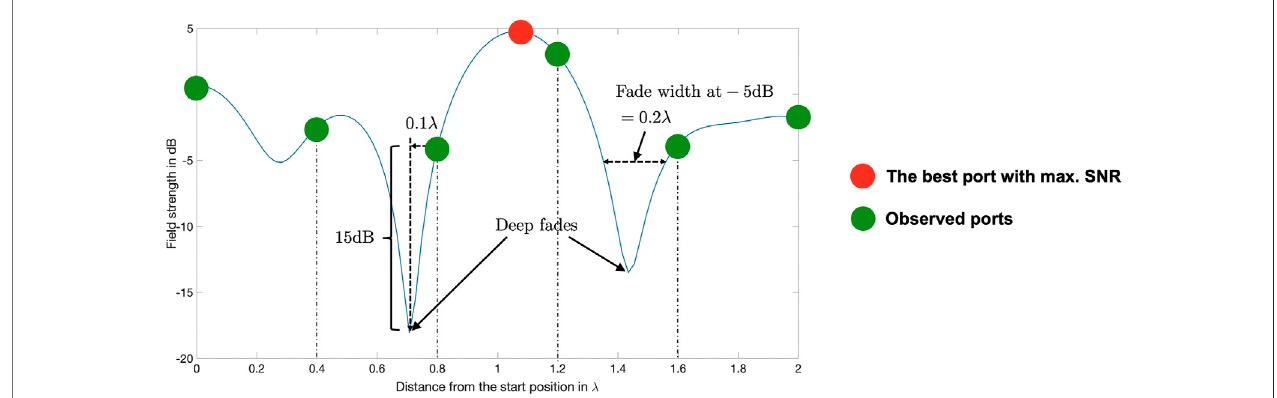
FIGURE 12 | Port selection of fl uid antenna with only limited